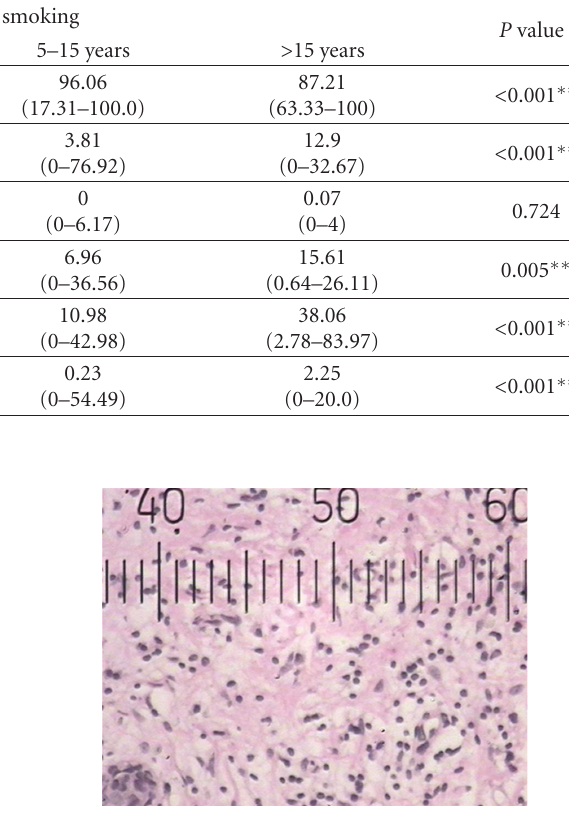
Figure 5: Histopathological photograph of gingival tissue in smoker showing inflammatory cells.